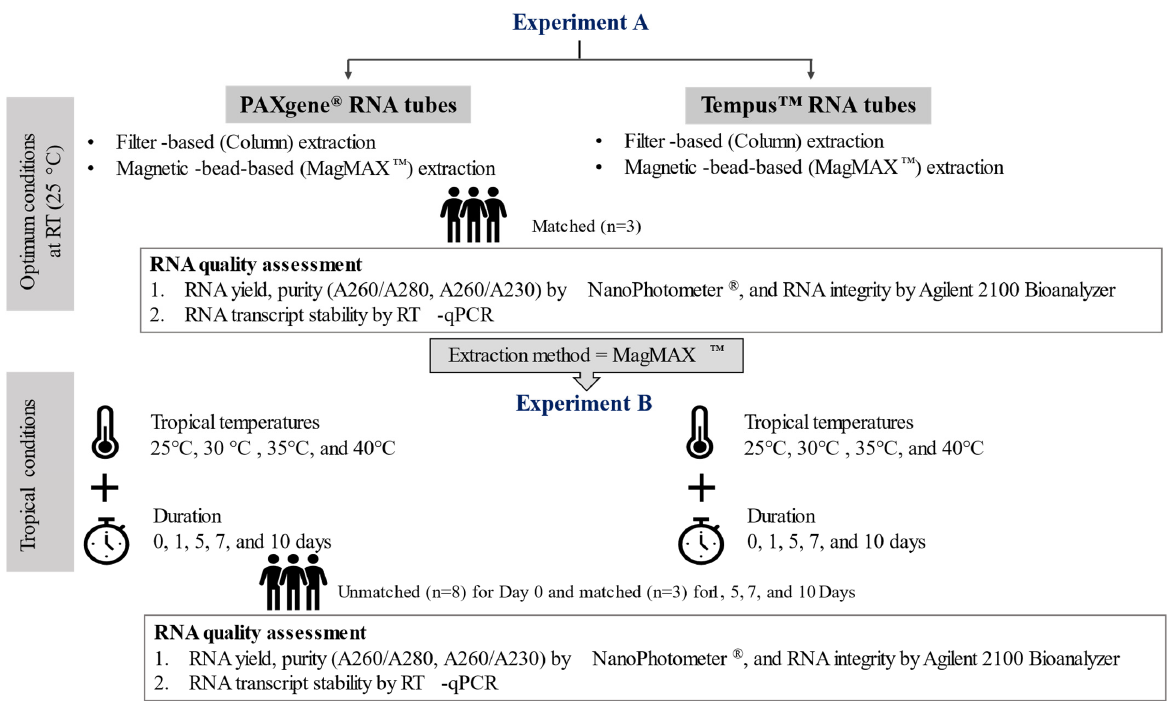
Figure 4. Experimental design. Experiment A. Comparison of total RNA yields, purity, and integrity using spin column-based and magnetic bead-based kits for the two types of blood stabilization systems (PAXgene ® Blood RNA Tubes and Tempus ™ Blood RNA Tubes). All RNA samples were extracted fresh post collection. Experiment B . Systematic testing of different temperatures (25, 30, 35, or 40 °C) and storage times (0, 1, 5, 7, or 10 days) were immediately frozen at − 80 °C for later extraction with matched samples ( n = 3). Samples immediately frozen at − 80 °C for later extraction is referred to “D1/Control”. Unmatched samples ( n = 8) collected in PAXgene ® or Tempus ™ RNA stabilizing systems and processed post collection immediately at optimal laboratory conditions (D0/Fresh).